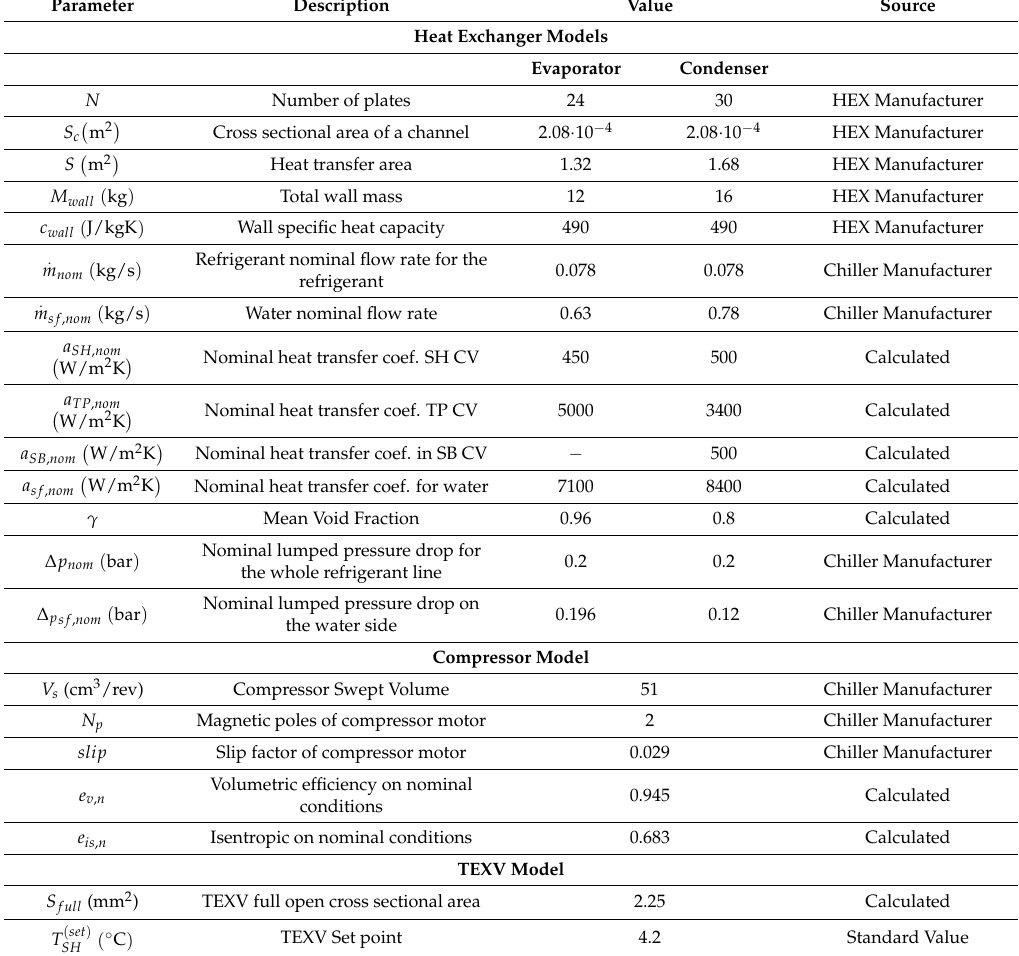
Table A3. Parameters used in the model of the compression